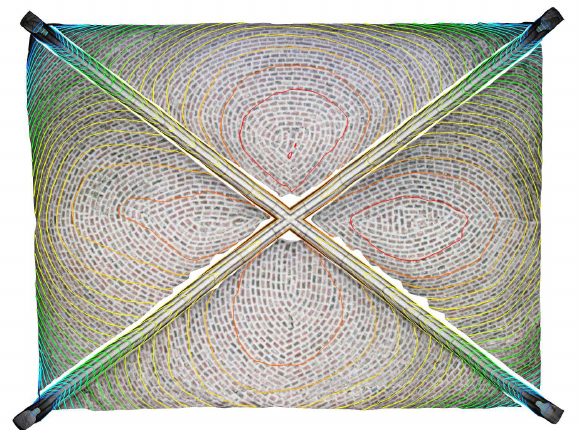
Figure 5: Projection of a photograph on the 3D model of a vault, section through the model to draw isolines. Humelghem, Bel-